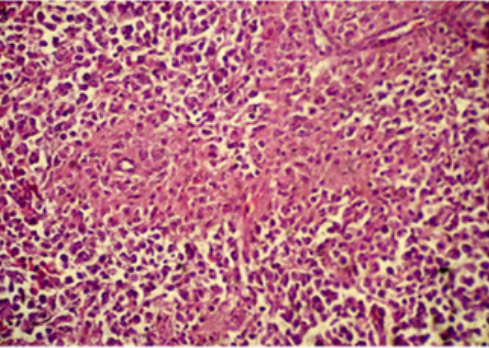
Figure 1: Photomicrograph of chicken spleen with small, medium and large sized lymphocyte along with white pulp composed of reticular cells which indicates extensive inflammatory reaction (× 400).